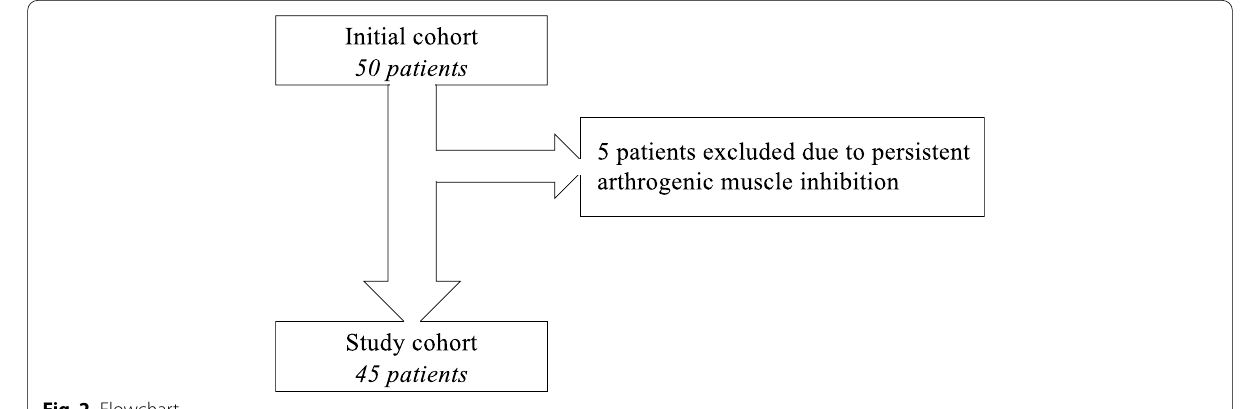
Table 1 Pre‑ and intra‑operative data